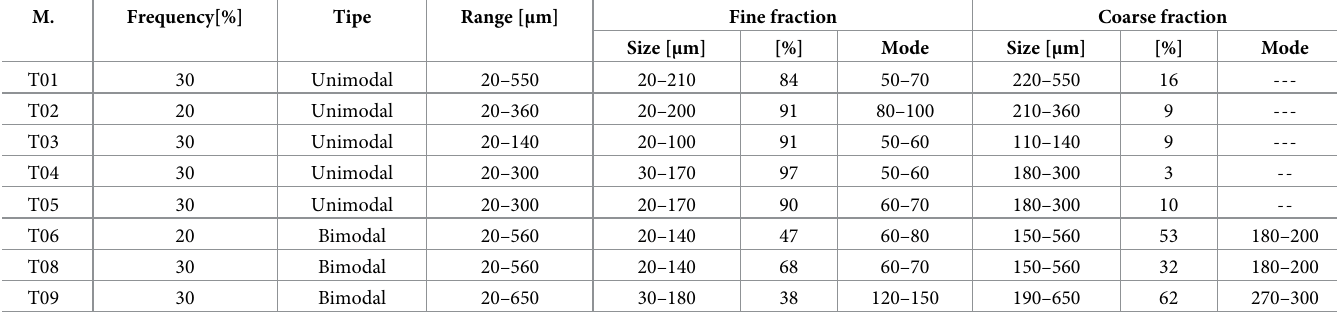
Table 6. Quantitative characterization aplastic